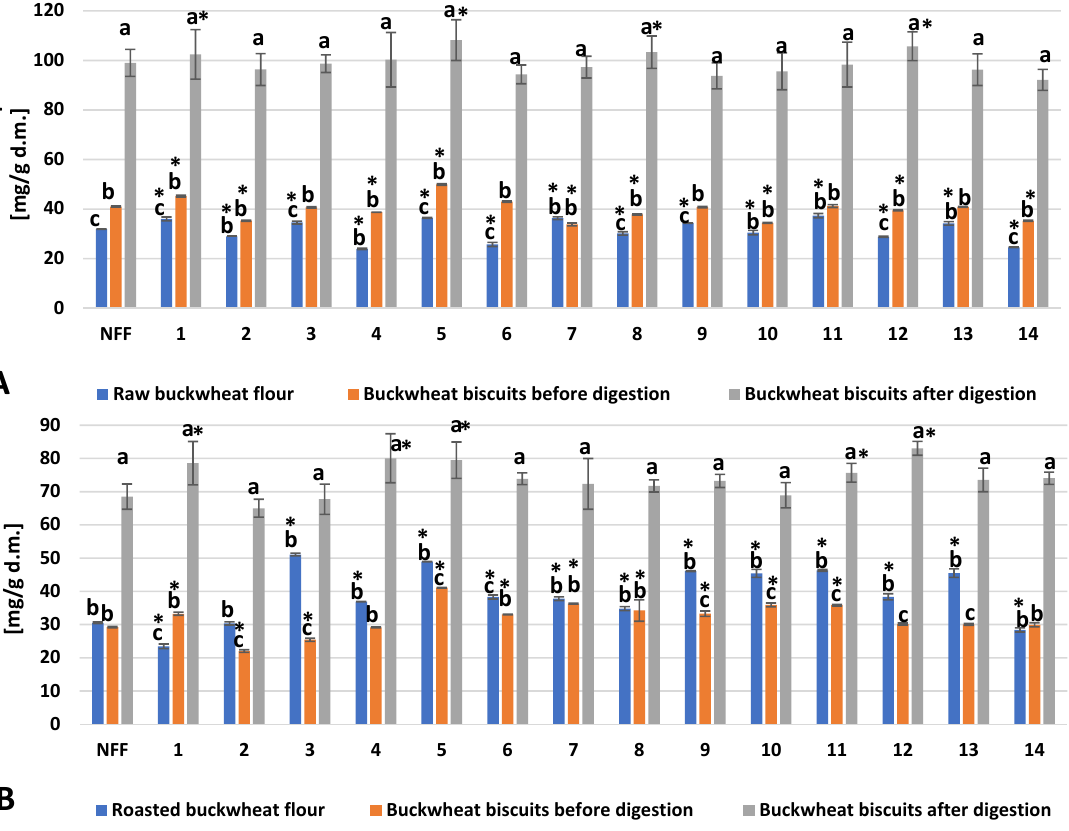
Figure 1. Content of soluble protein in raw ( A ) and roasted ( B ) buckwheat flour fermented with selected strains of lactic acid bacteria and in buckwheat biscuits before and after in vitro digestion (mg/g d.m.). Data are expressed as mean ± standard deviation ( n = 3). * Upper star means the significant differences at p < 0.05 of fermented samples as compared to the control sample based on Student’s t-test. A letter means significant differences at p < 0.05 based on one-way ANOVA. NFF— nonfermented flour. Flours fermented by: 1 —Lactiplantibacillus plantarum IB; 2—